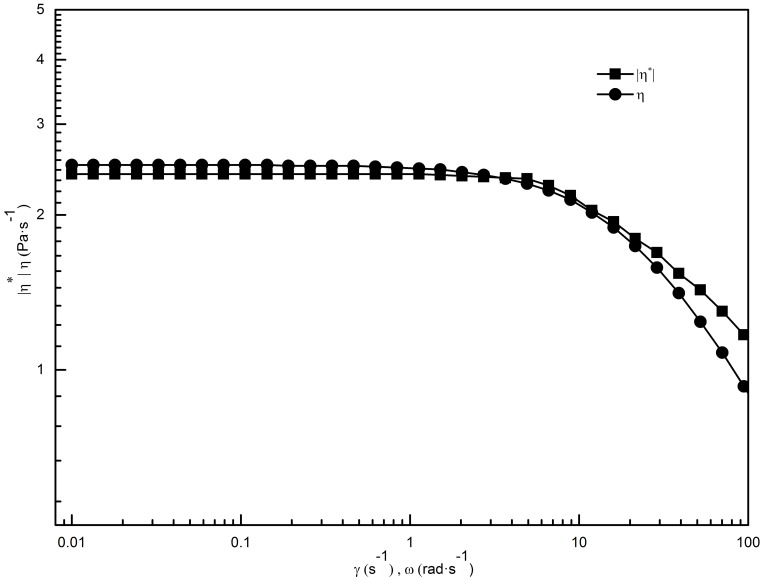
Shear-rate dependence of the steady-shear viscosity and frequency dependence of the complex viscosity for the 70 mM C16MDB/35 mM SL solution.